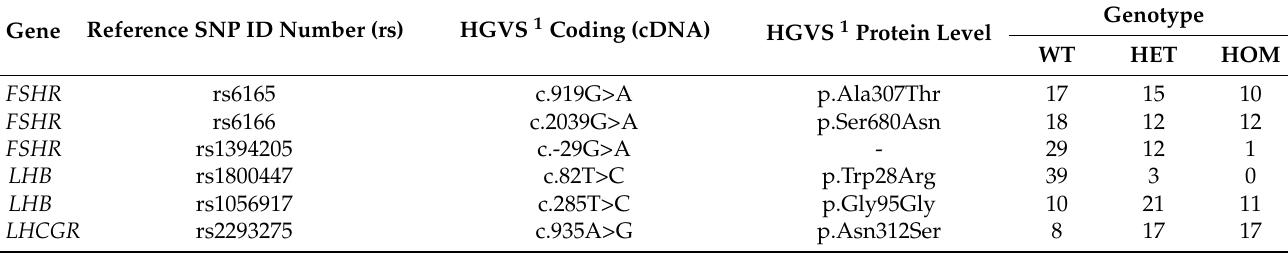
Table 2. Distribution of polymorphisms related to ovarian stimulation outcomes among the 42 women analyzed in the present